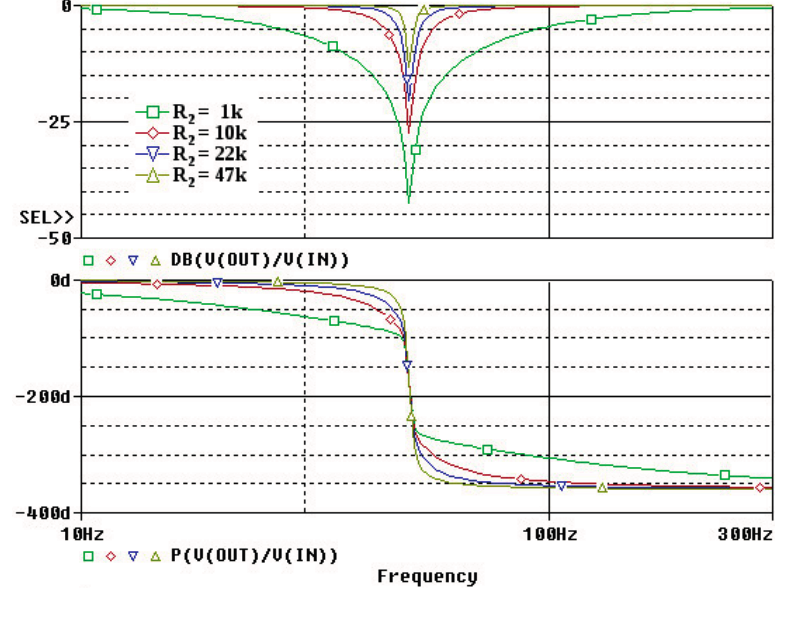
Figure 10. Bode response of the used double T 50 Hz notch